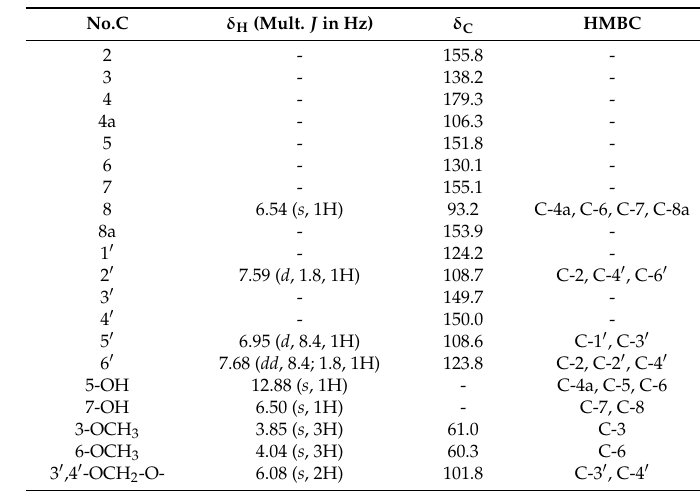
Table 1. NMR spectroscopic data of 5,7-dihydroxy-3,6-dimethoxy-3 (cid:48) ,4 (cid:48) -methylenedioxyflavone in CDCl 3